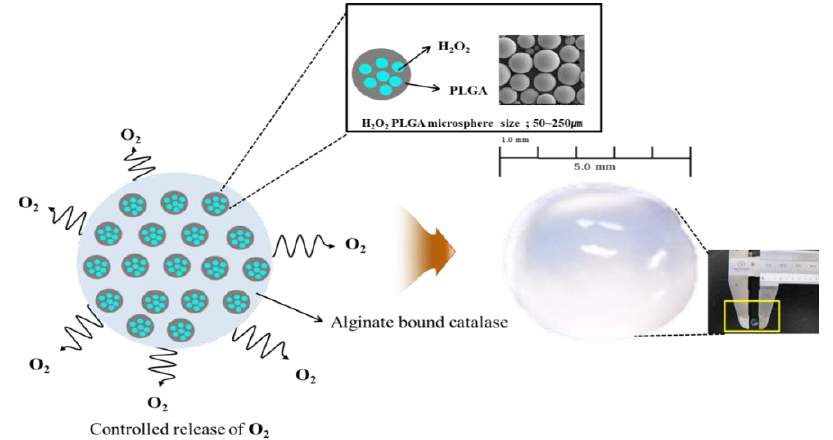
Figure 1. Concept of oxygen-releasing system for large-sized tissue regeneration; enhancement of cell and tissue survival by supply of oxygen.